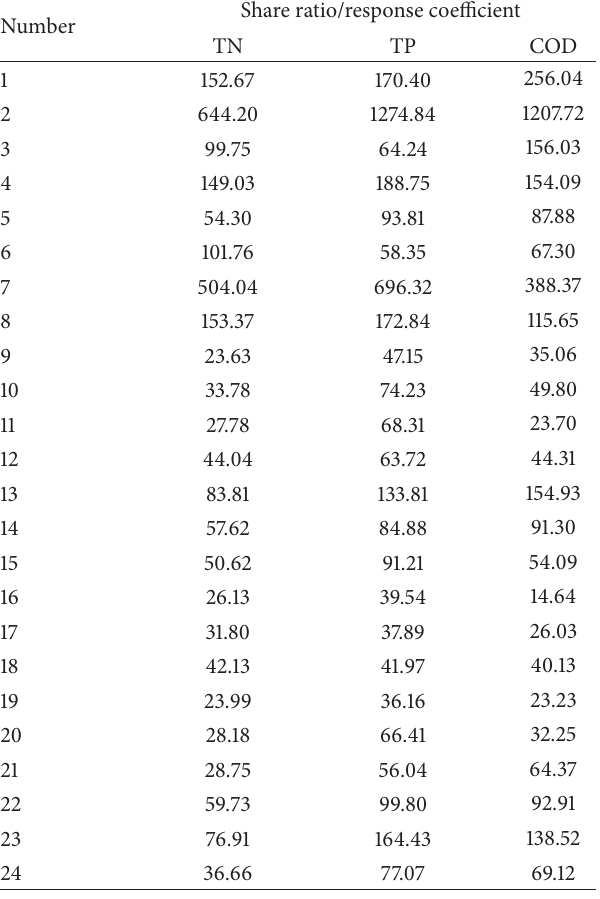
Table 2: The relations between response coefficient and share ratio.